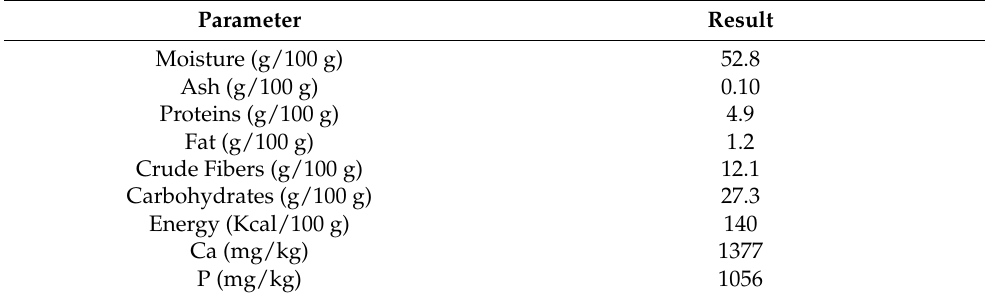
Table 2. Chemical composition of pomegranate peel byproduct used in this